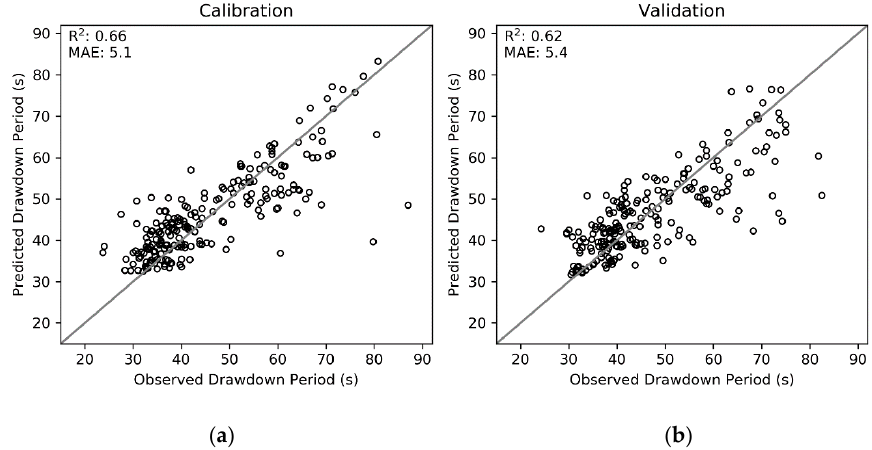
Figure 11. Predicted drawdown period with the newly derived equation plotted against observed drawdown period for a typical data set used for calibration ( a ) and validation ( b ). The grey line displays the perfect fit between observed and predicted drawdown.